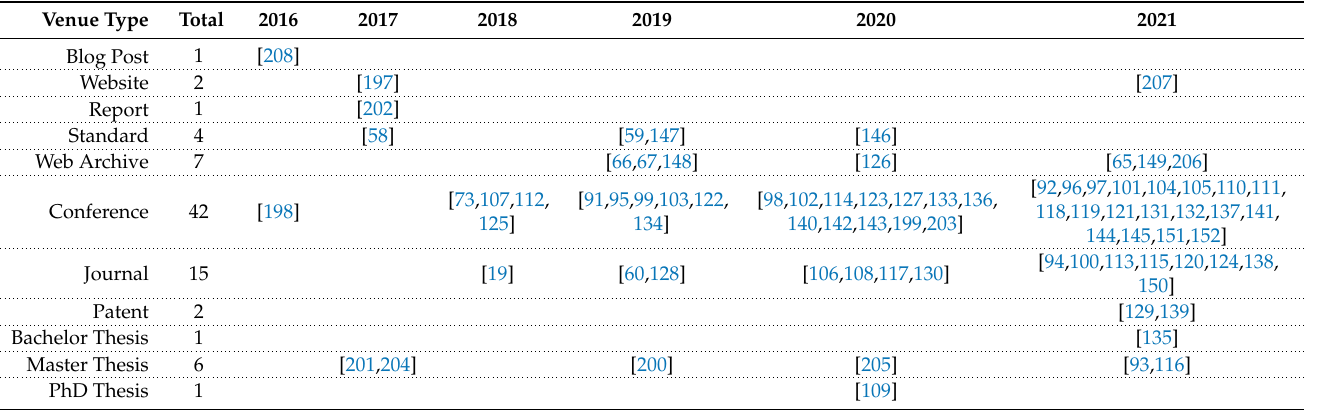
Table 9. Types of publishing venues over the